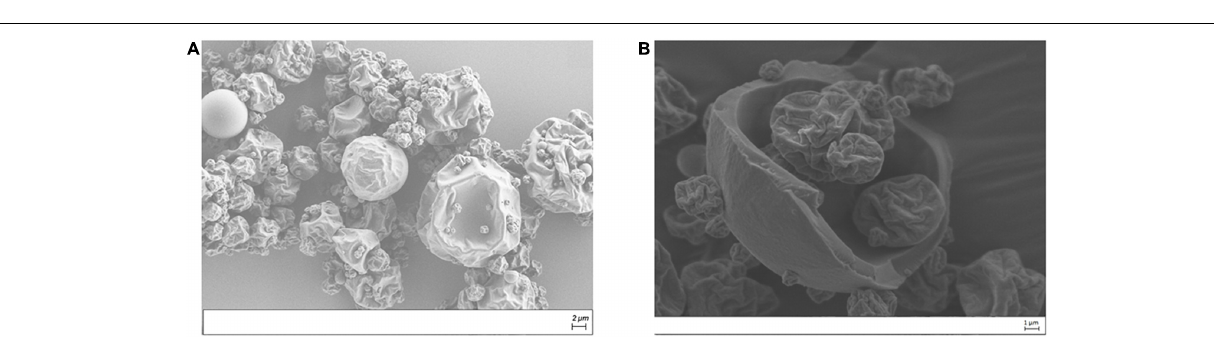
FIGURE 2 | Scanning electron microscope (SEM) micrographs of spray-dried solution containing 1 g of RuL3 and 50 g of maltodextrin DE 19 in imidazole acetate buffer at pH 7 [external (A) and internal (B)